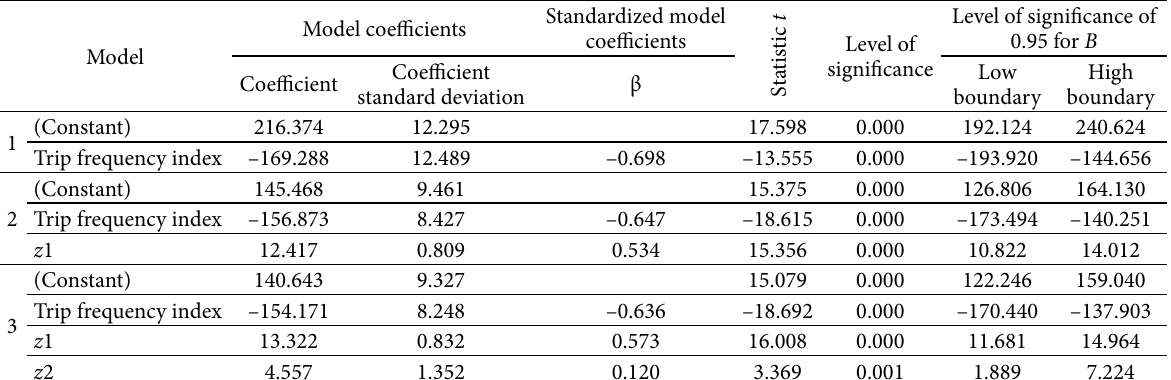
Table 3. Determining the calibration coefficient in the new